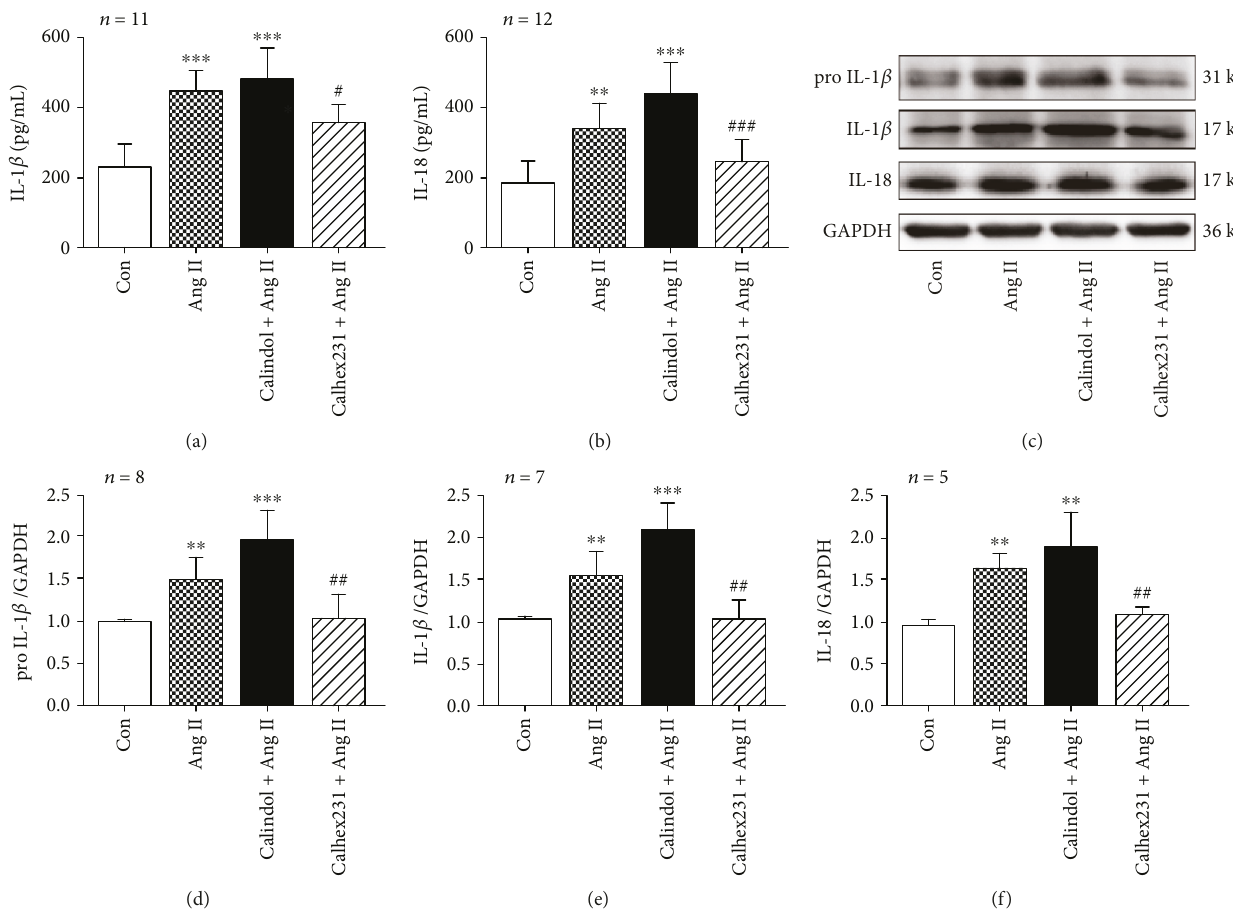
Figure 4: Calhex 231 inhibited the release of IL-1 β and IL-18 in VSMCs induced by Ang II. (a, b) IL-1 β and IL-18 levels measured with enzyme-linked immunosorbent assay (ELISA). (c) Western blot images of pro-IL-1 β , IL-1 β , and IL-18. (d – f) Quantitative analyses of the proteins from C. ∗∗ P < 0 01 , ∗∗∗ P < 0 001 vs. control; # P < 0 05 , ## P < 0 01 , and ### P < 0 001 vs. Ang